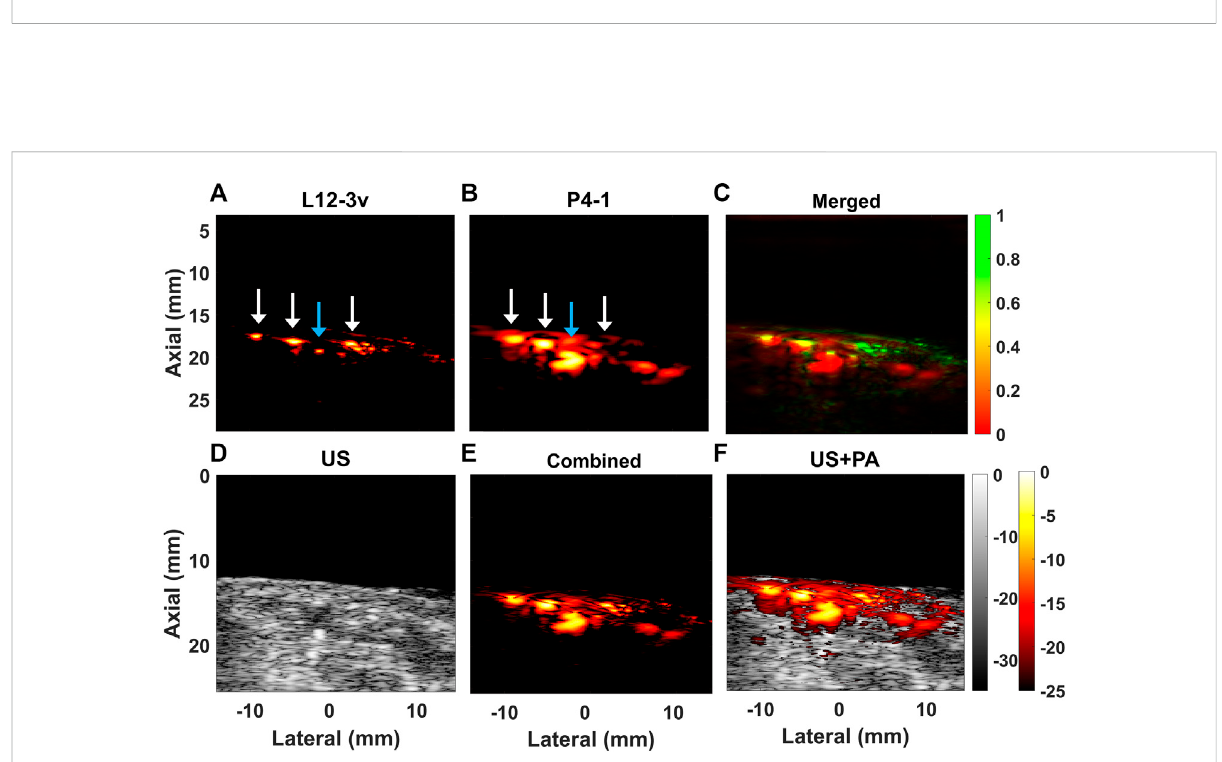
FIGURE 9 ReconstructedPAB-modecross-sectionalimagesobtainedfromhumanbloodvesselsfromthevolarwristat800 nmwith (A) L12-3v, (B) P4-1, and (C) merged image obtained from the L12-3v and P4-1. (D) Shows the US B-mode acquired with L12-3v (E) image obtained after combining beamformedRF from L12-3v and P4-1 and (F) shows a superpositionof (E) on (D) . The white arrowsindicate super fi cial veins and the blue arrow the ulnar